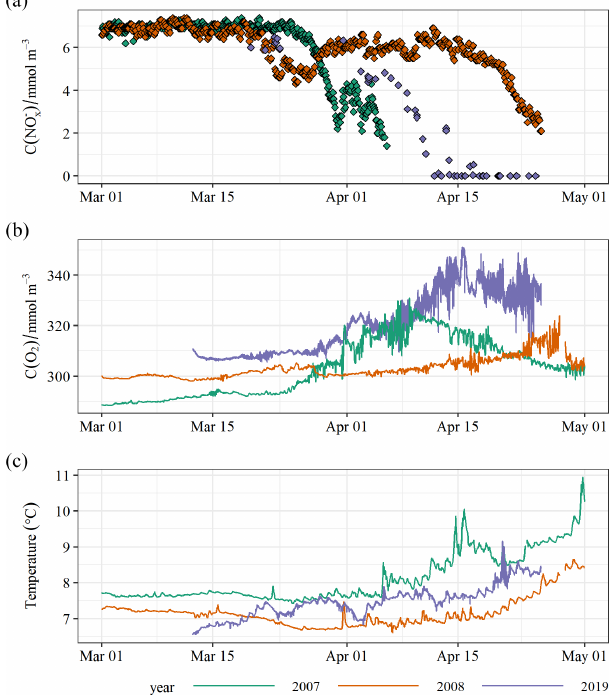
Figure 6. NO x − and oxygen concentration observations from the 2007–2008 North Dogger Cefas SmartBuoy mooring together with the 2019 AlterEco Seaglider (this study). NO x − and temperature observations are from 1m depth, while oxygen concentrations are from 25m in 2007 and 35m in 2018. For 2019 all data between these depths are